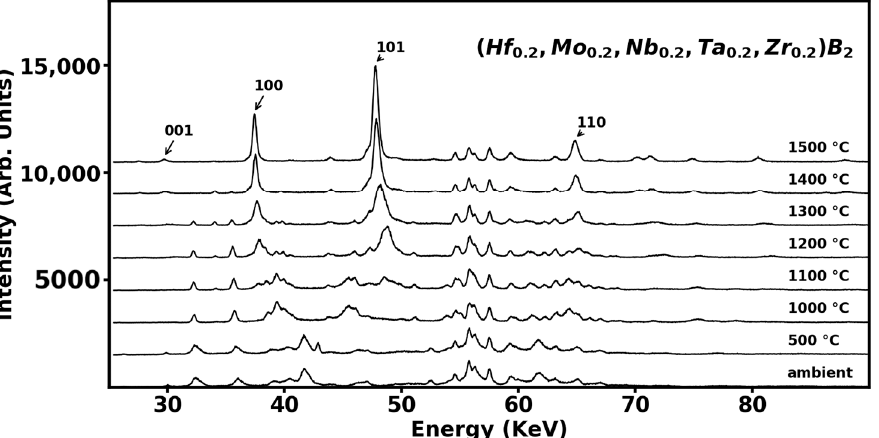
Figure 2 . Energy-dispersive x-ray diffraction pattern of ball-milled powder mix of HfO 2 , MoO 3 , Nb 2 O 5, Ta 2 O 5 , ZrO 2 , carbon black, and boron carbide at various temperatures. The transformation begins at 1100 °C and by 1500 °C the (001), (100), (101) and (110) peaks of the hexagonal AlB 2 -type phase of (Hf 0.2 , Mo 0.2 , Nb 0.2 , Ta 0.2 , Zr 0.2 )B 2 are apparent.